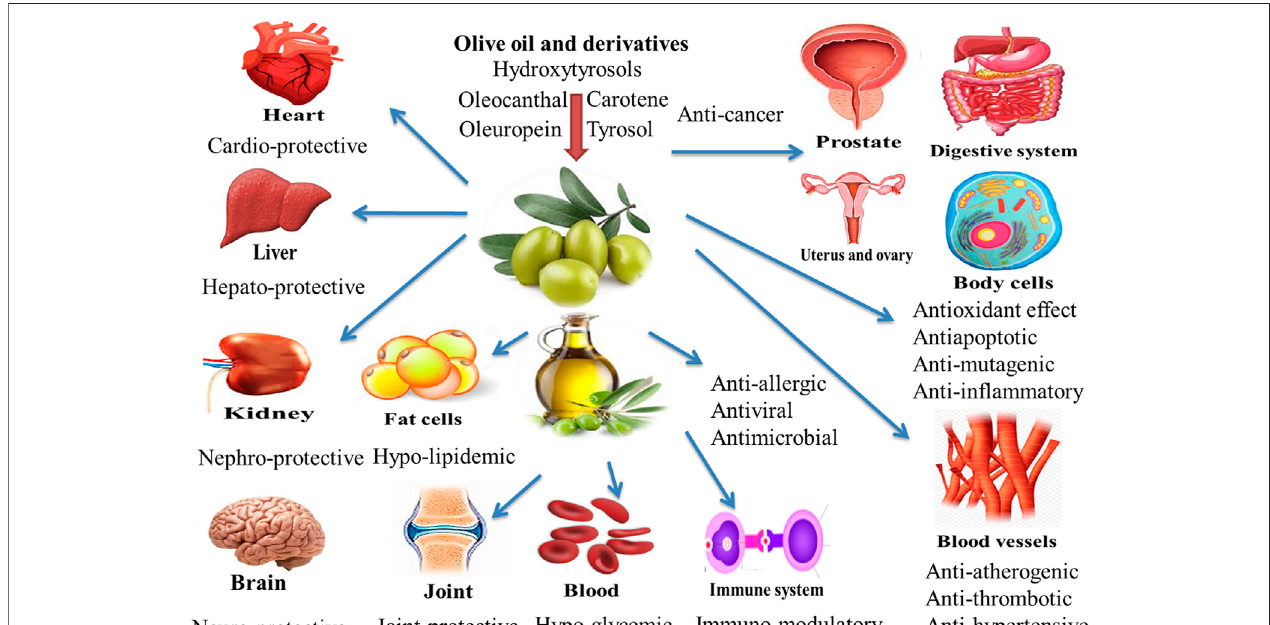
FIGURE 1 | Health bene fi ts and nutritional applications of olive